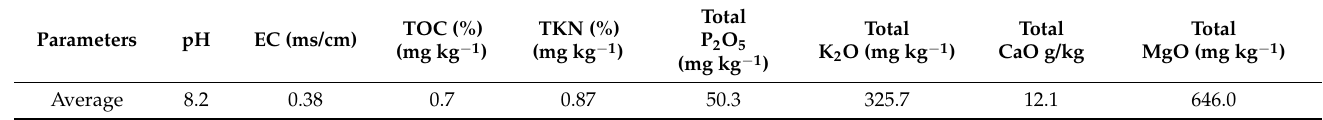
Table 1. Physicochemical properties of the used